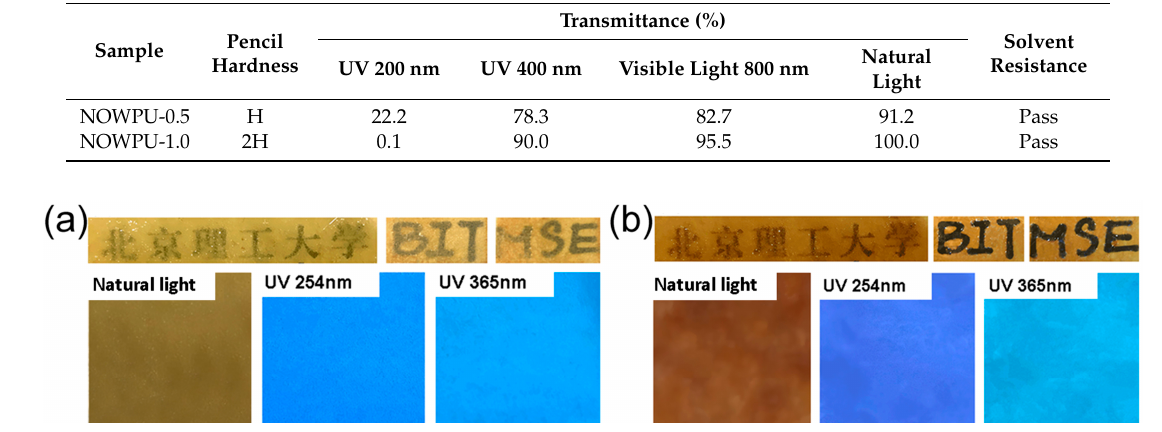
Table 5. Pencil hardness, transmittance and solvent resistance of NOWPU-0.5 and NOWPU-1.0.